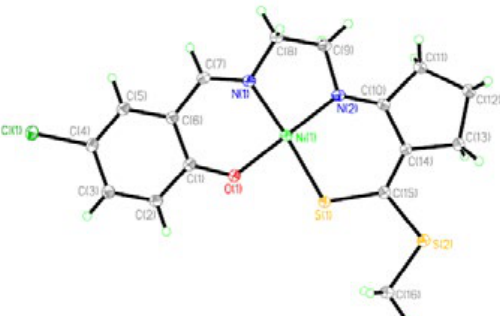
Fig. 7 Molecular structure of the complex [Ni(cd5-Clsalen)] with the atom numbering scheme. Displacement ellipsoids are drown at the 50% probability level.